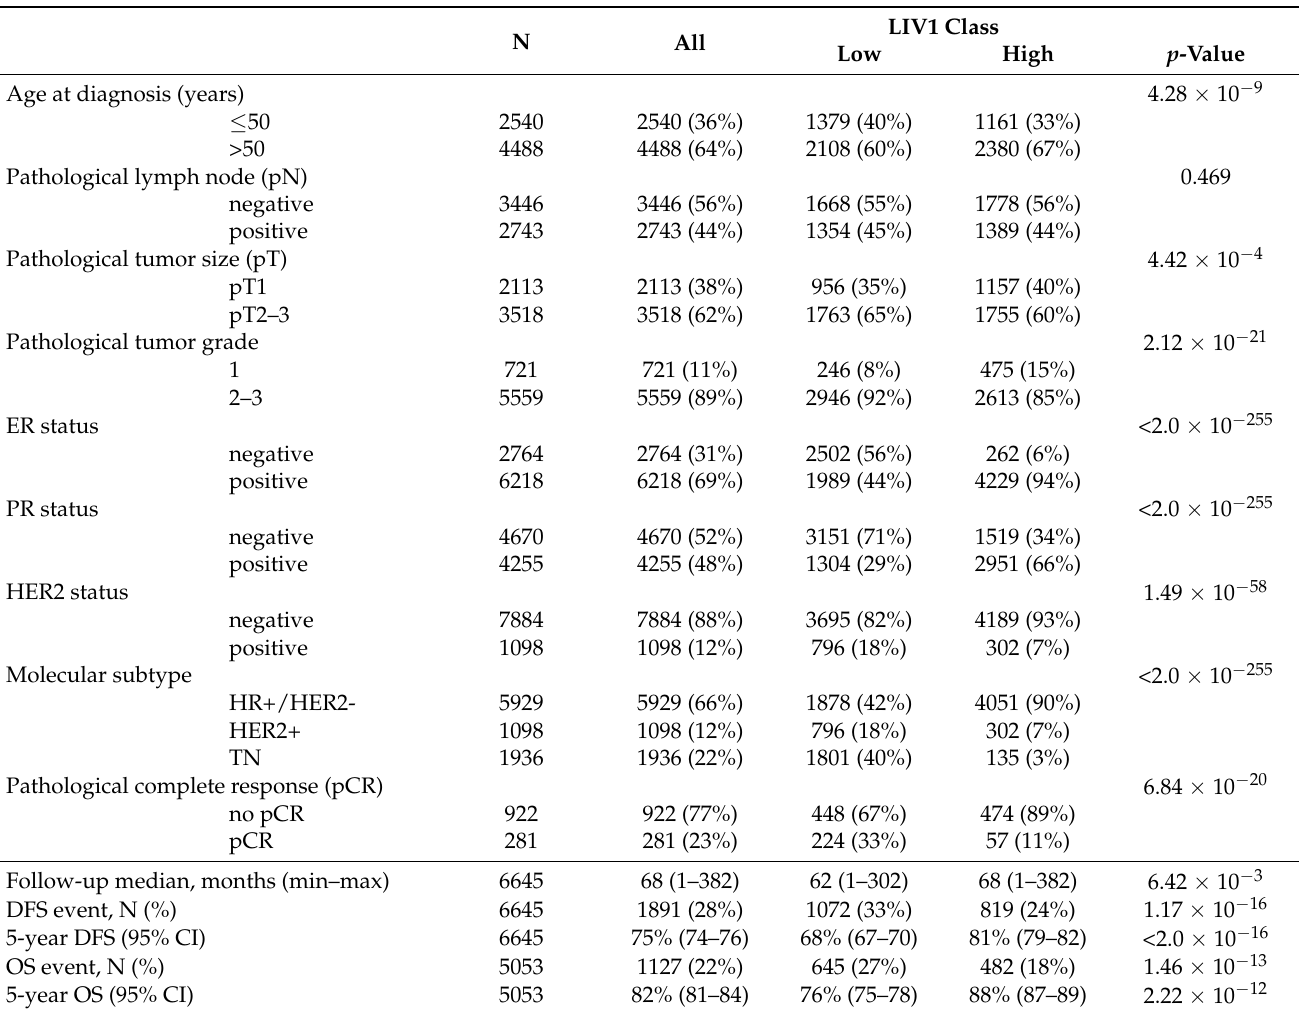
Table 1. Clinicopathological characteristics of the whole population and correlations with LIV1 expression